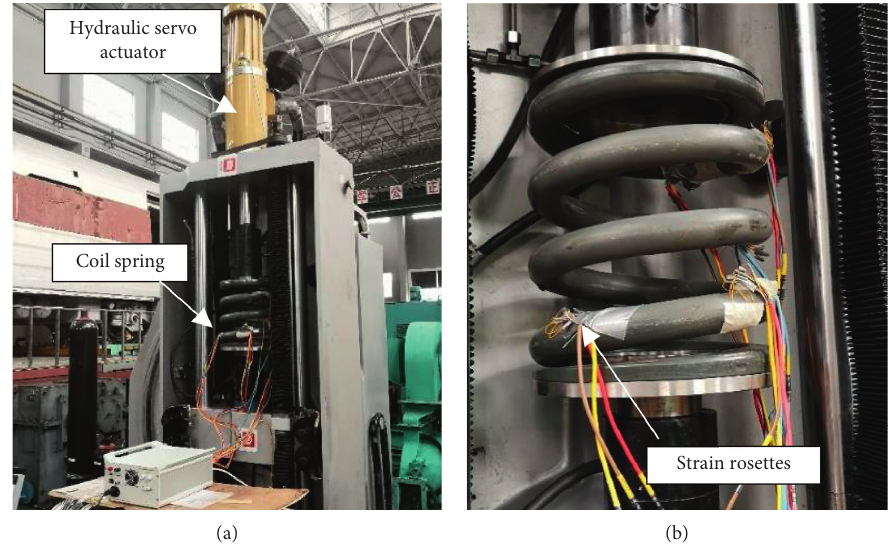
Figure 7: Dynamic characteristic test of coil spring. (a) Dynamic characteristic test bench. (b) Installation status of coil